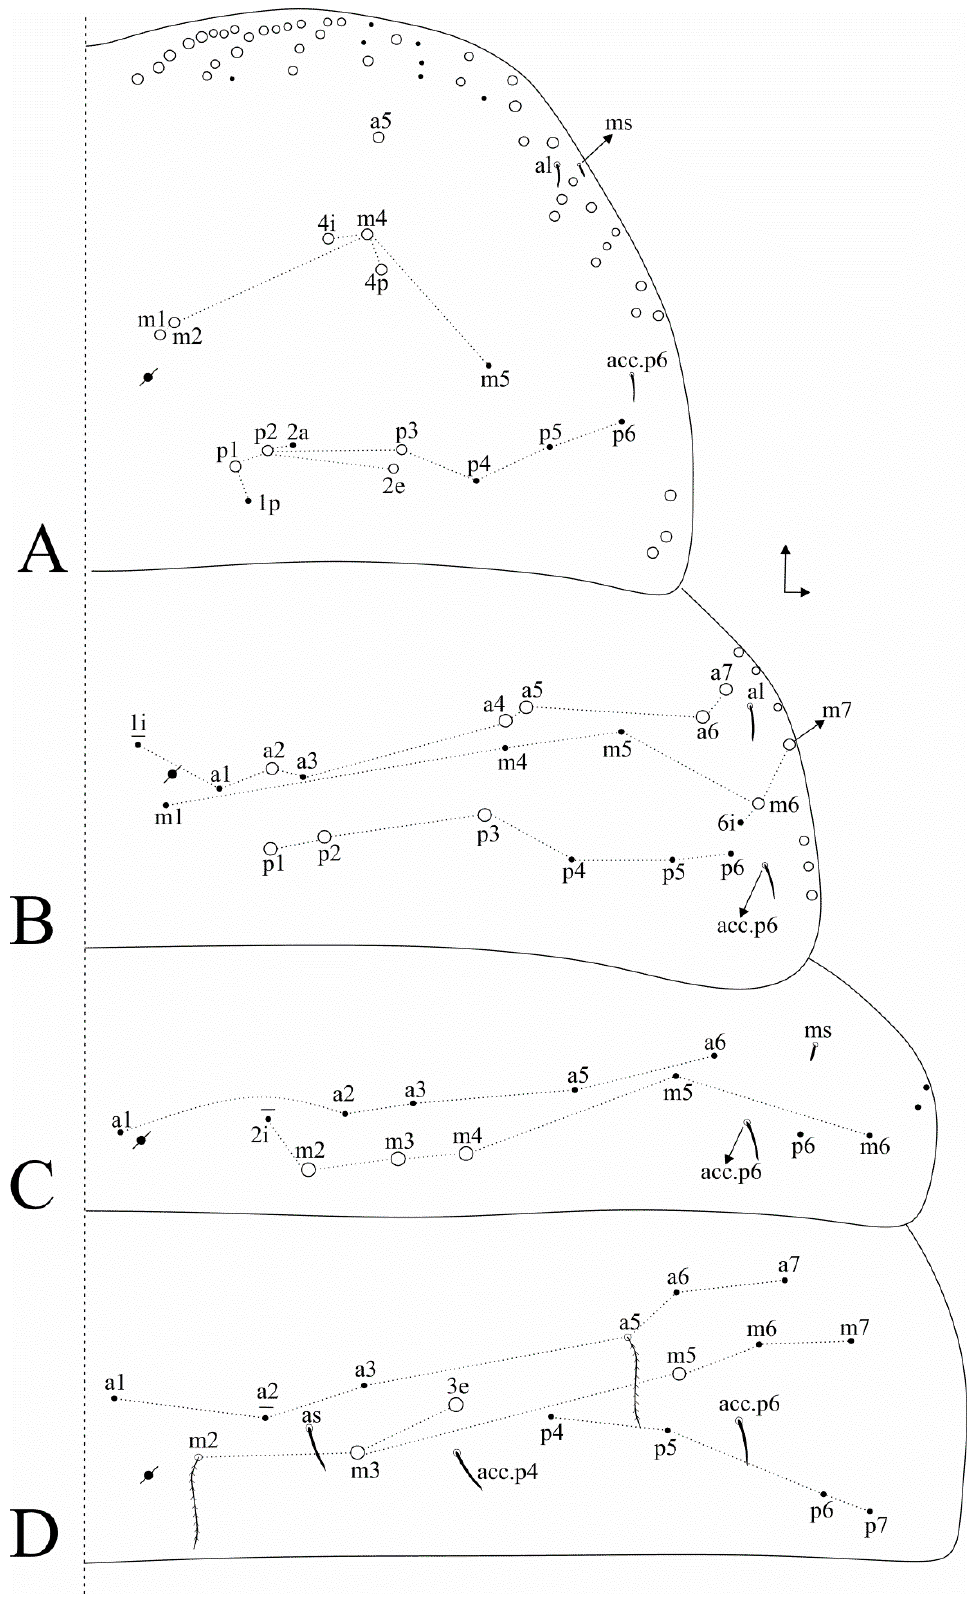
Figure 4. Dicranocentrus abestado sp. nov. trunk dorsal chaetotaxy (right side): ( A ) Th. II; ( B ) Th. III; ( C ) Abd. I; ( D ) Abd. II.